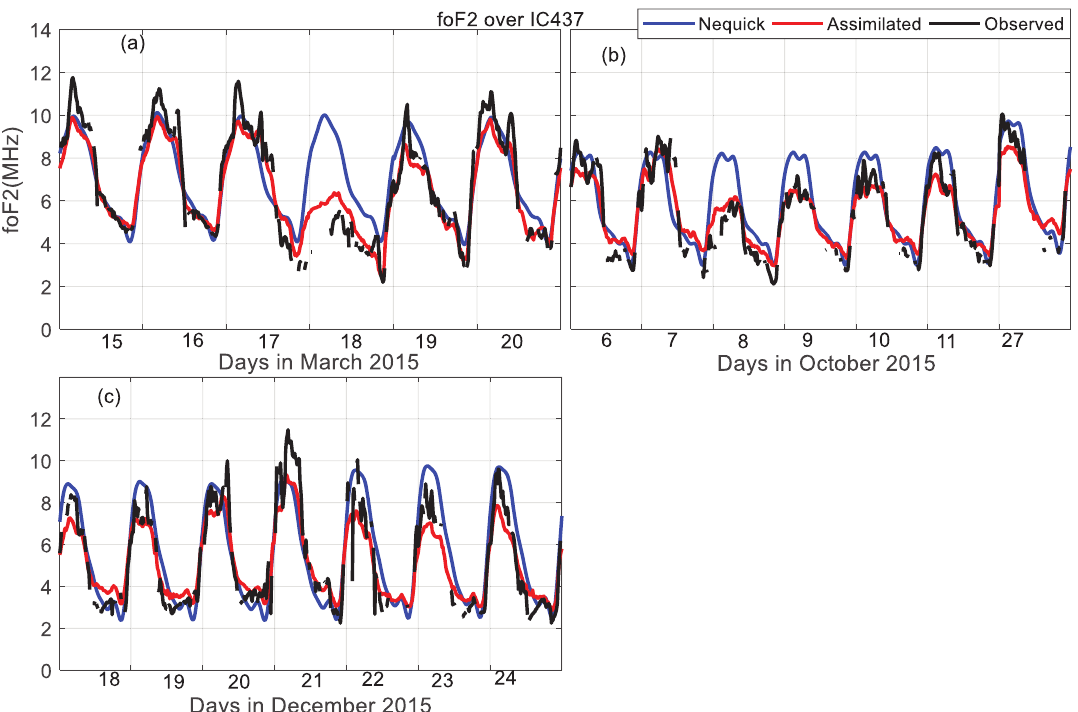
Figure 4. Panels (a), (b), and (c) present variation of foF2 during March 15 – 20, October 6 – 11, 27, and December 18 – 24, 2015, respectively over IC437. The blue, red, and black colors represent NeQuick model generated parameter, assimilation result, and observed parameter.